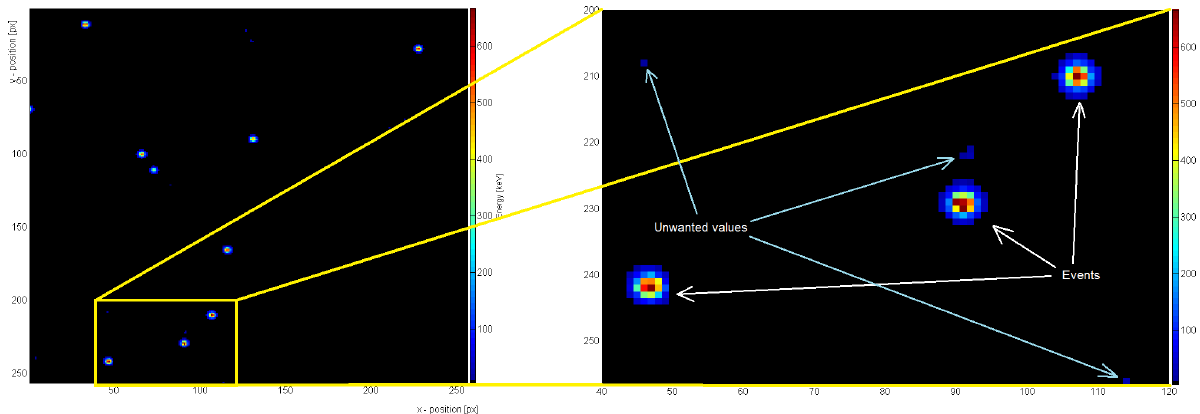
Figure 1. One frame with cropped selection. The left figure shows one frame of radiographic data. This frame contains 9 suitable events and few unwanted values which are recorded by X-rays. Three suitable events and three unwanted values are shown on the right figure, where it is displayed the cropped area from left